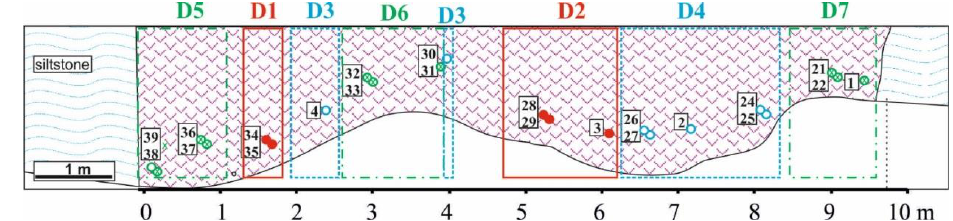
Figure 11. Locations of different domains with normal (open circles), inverse (solid circles), and oblique (crossed circles) magnetic fabrics across the lamprophyre dyke in Dob říš .